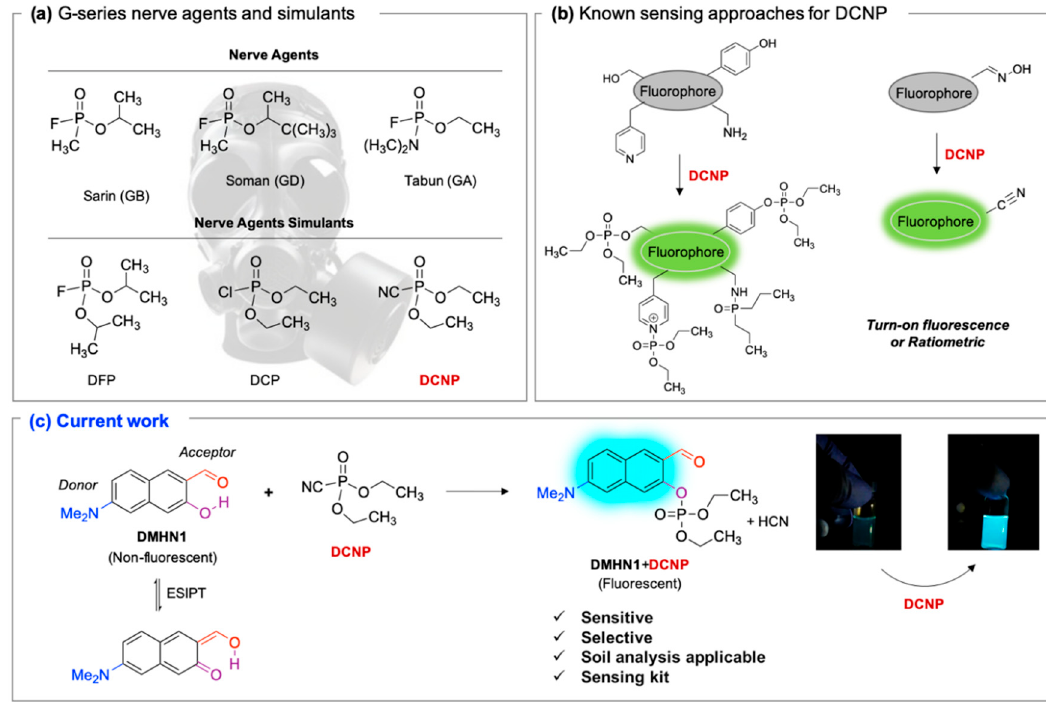
Figure 1. ( a ) G-series nerve agents for chemical warfare and their simulants. ( b ) Representative sensing mechanism of known probes for diethylcyanophosphonate (DCNP). See Table 1 for detail structure and information. ( c ) Sensing mechanism of 6-(dimethylamino)-3-hydroxy-2-naphthaldehyde ( DMHN1) and DCNP. Schematic illustrations of sensing mode, excited state intramolecular proton transfer (ESIPT) product, merits, and practical applicability. Inset: photos of DMHN1 in the solution before and after treatment with DCNP under UV light (365 nm).